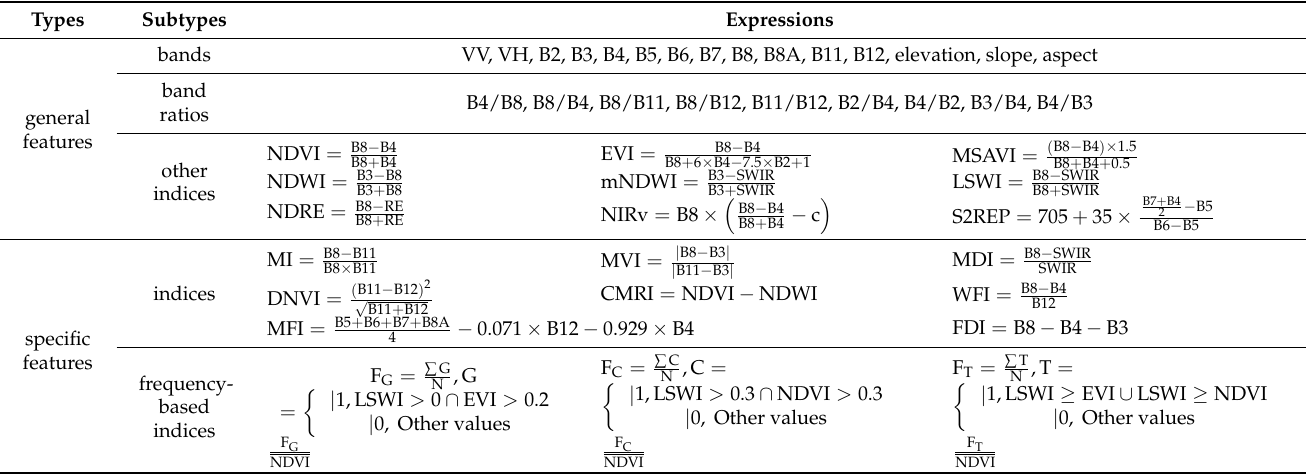
Table 1. Features used in the